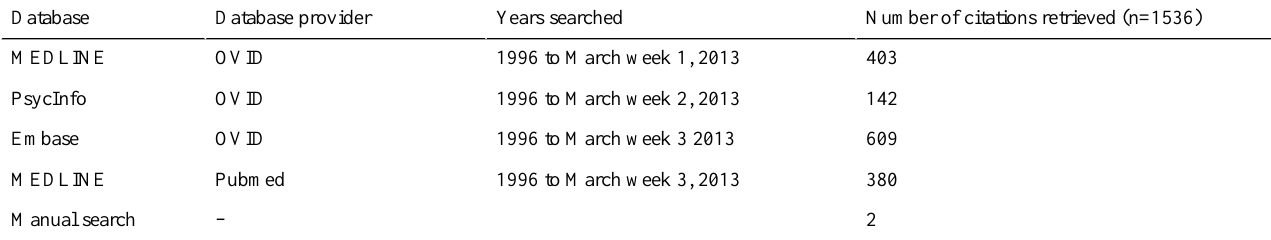
Table 1. Database search